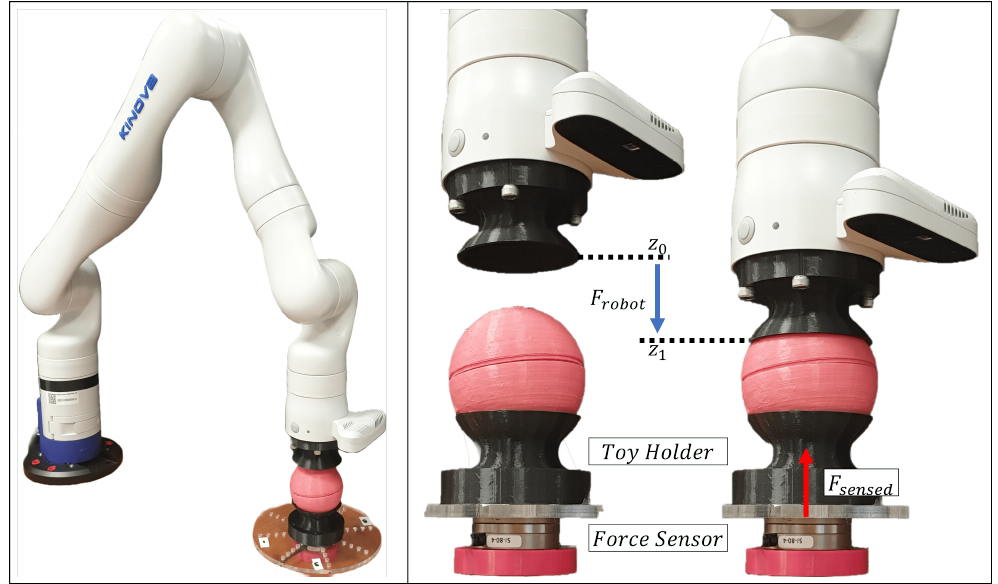
Figure 7. Kinova Gen3 7 DoF Robot applying a squeezing force on instrumented